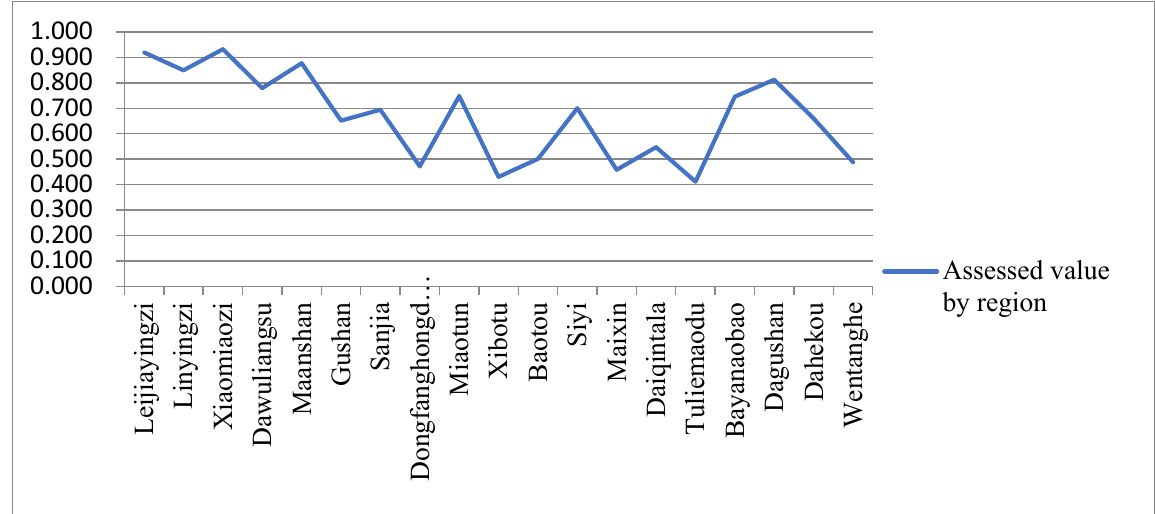
Figure 3. Value assessment of rural preservation and inheritance in the Western Liao River Basin, Inner Mongolia, China, by year.